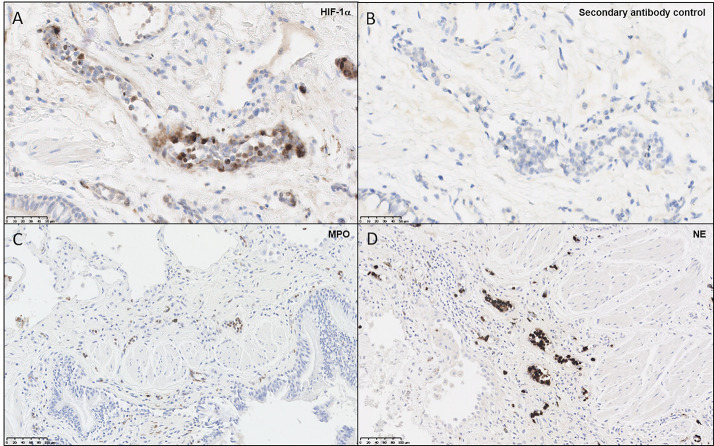
Neutrophils and endothelial cells express HIF-1α within the ILD lung. Paraffin-embedded from four lung biopsies from patients with fibrotic ILD, taken to determine clinical diagnosis of etiology, were cut and stained for immunohistochemical evidence of hypoxia and neutrophil infiltration. Images shown are representative of the four patients, from a patient diagnosed with IPF. (A) Slides stained for HIF-1α displayed positive brown staining within microvascular endothelial cells and polymorphonuclear cells, whilst (B) secondary antibody controls did not display positive staining. To verify whether neutrophils were present in the ILD lung, additional stains were performed for (C) MPO and (D) NE, both of which displayed positive brown stains within blood vessels. HIF-1α, hypoxia-inducible factor 1α; MPO, myeloperoxidase; NE, neutrophil elastase.